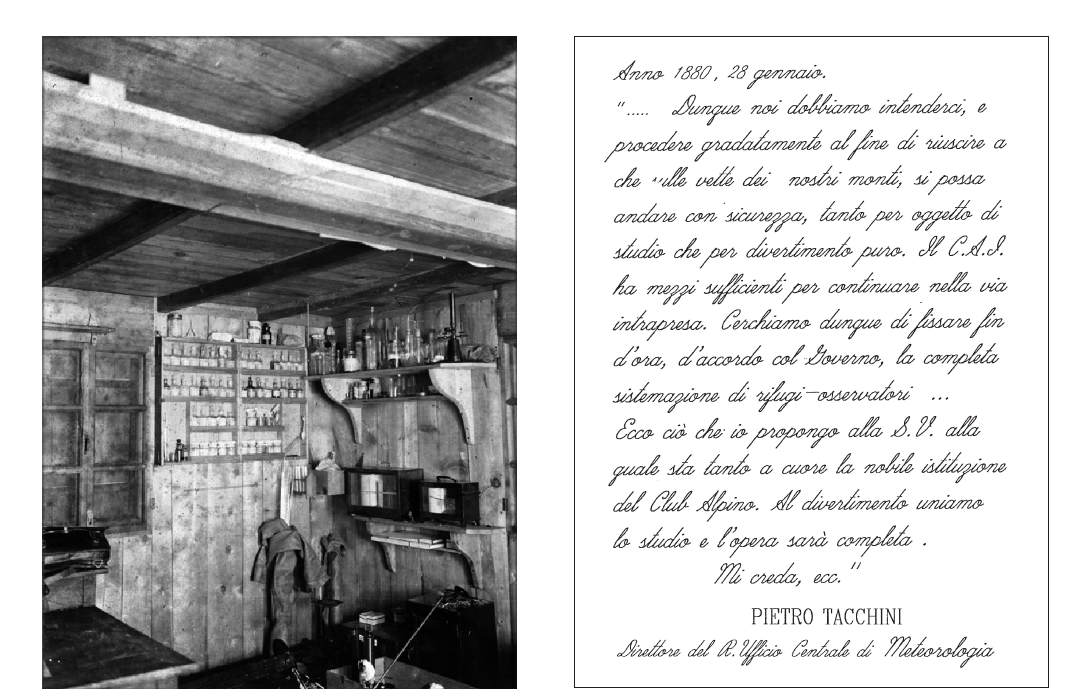
Fig. 7. Inner room and instruments of Capanna. Fig. 8. Tacchini’s letter to Quintino Sella president of CAI (Club Alpino Italiano) regarding the building of Capanna Margherita on Monte